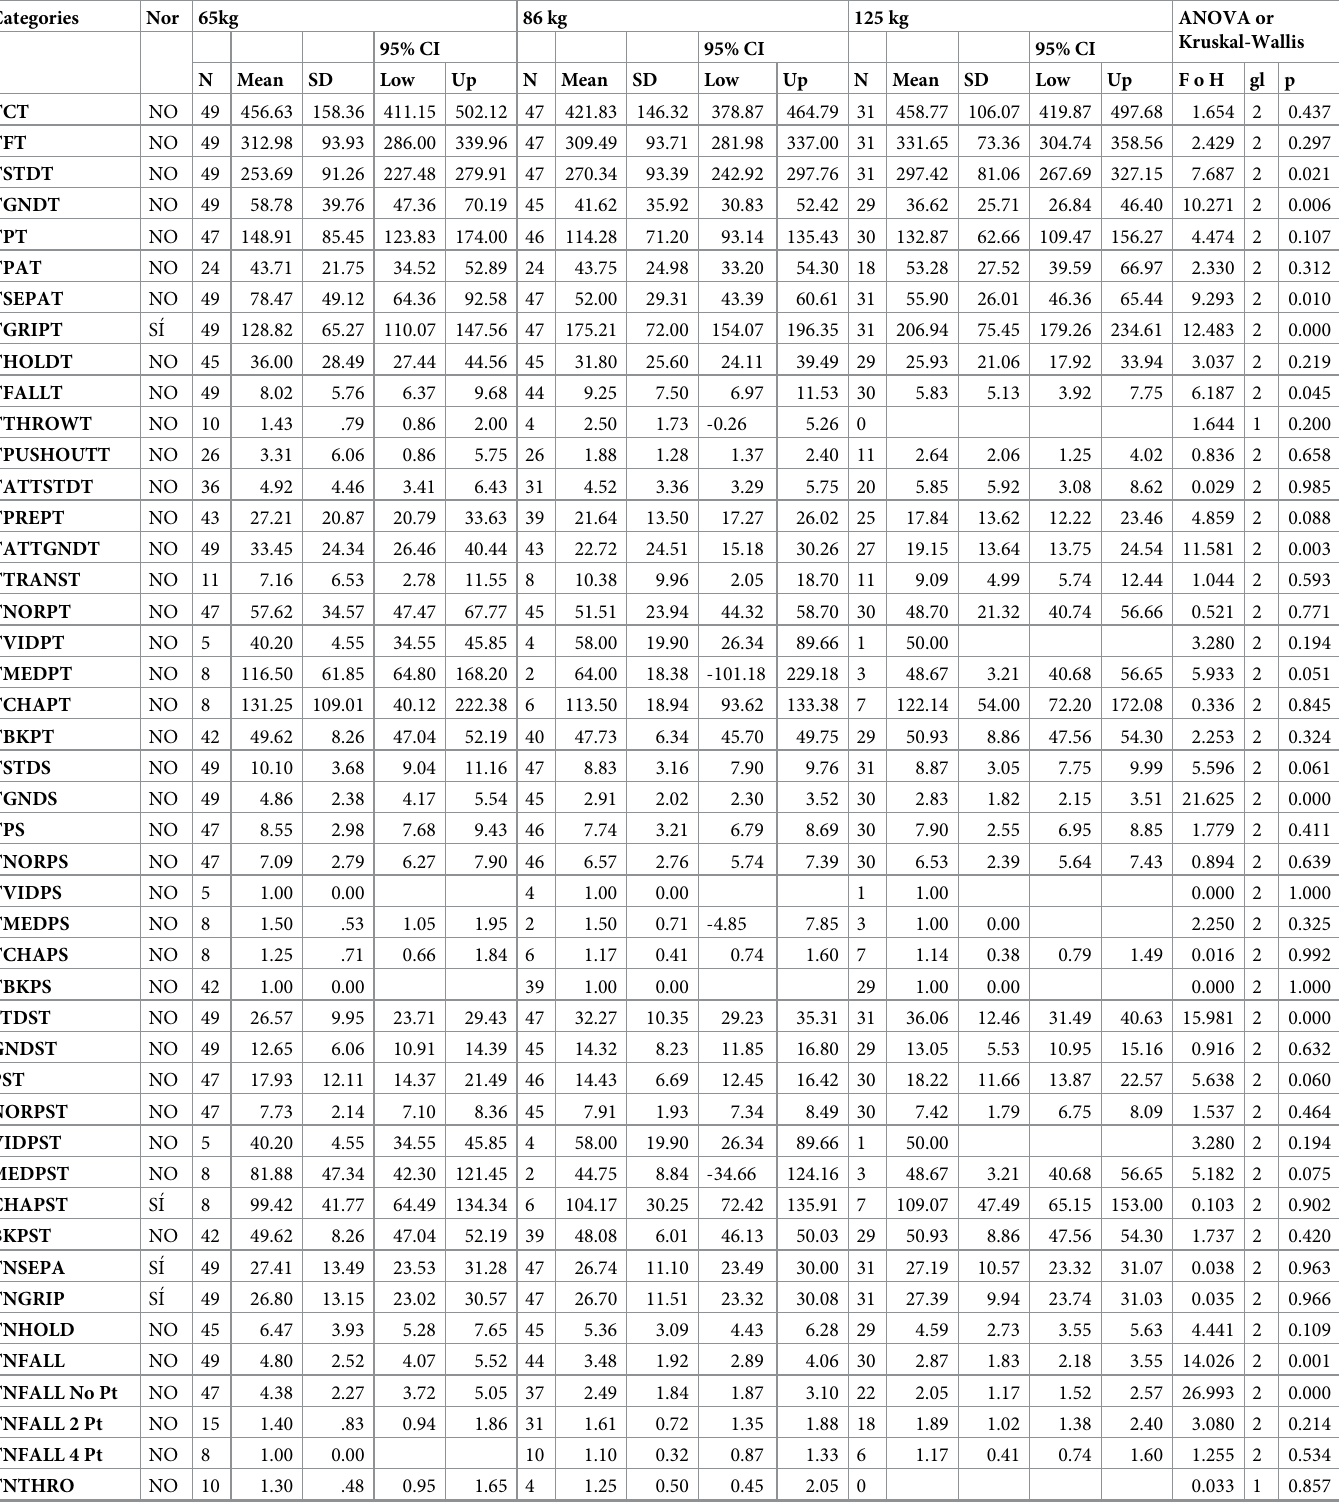
Table 3. Sequential and temporary parameters in the 65, 86 and 125kg categories.